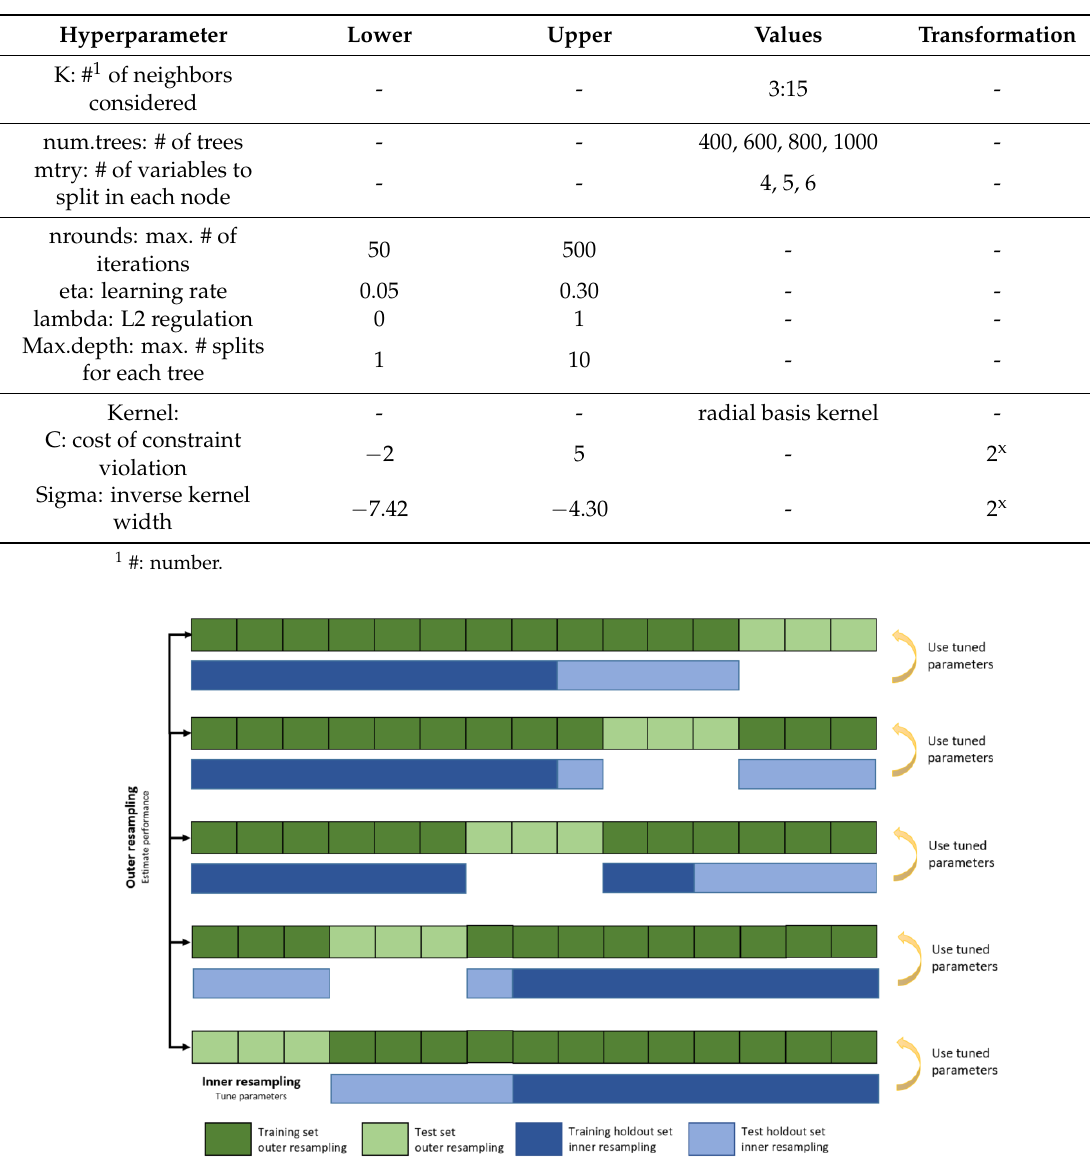
Table 2. Hyperparameter configuration space for model tuning. The table shows the lower and upper bounds of each ML model’s hyperparameters we tuned using iterated F-racing. The knn and rf are tuned using a grid search over the hyperparameter values shown in column “Values”. The values of the hyperparameters C and sigma of the svm have been transformed for the tuning process by the transformation function shown in the last column of the table.